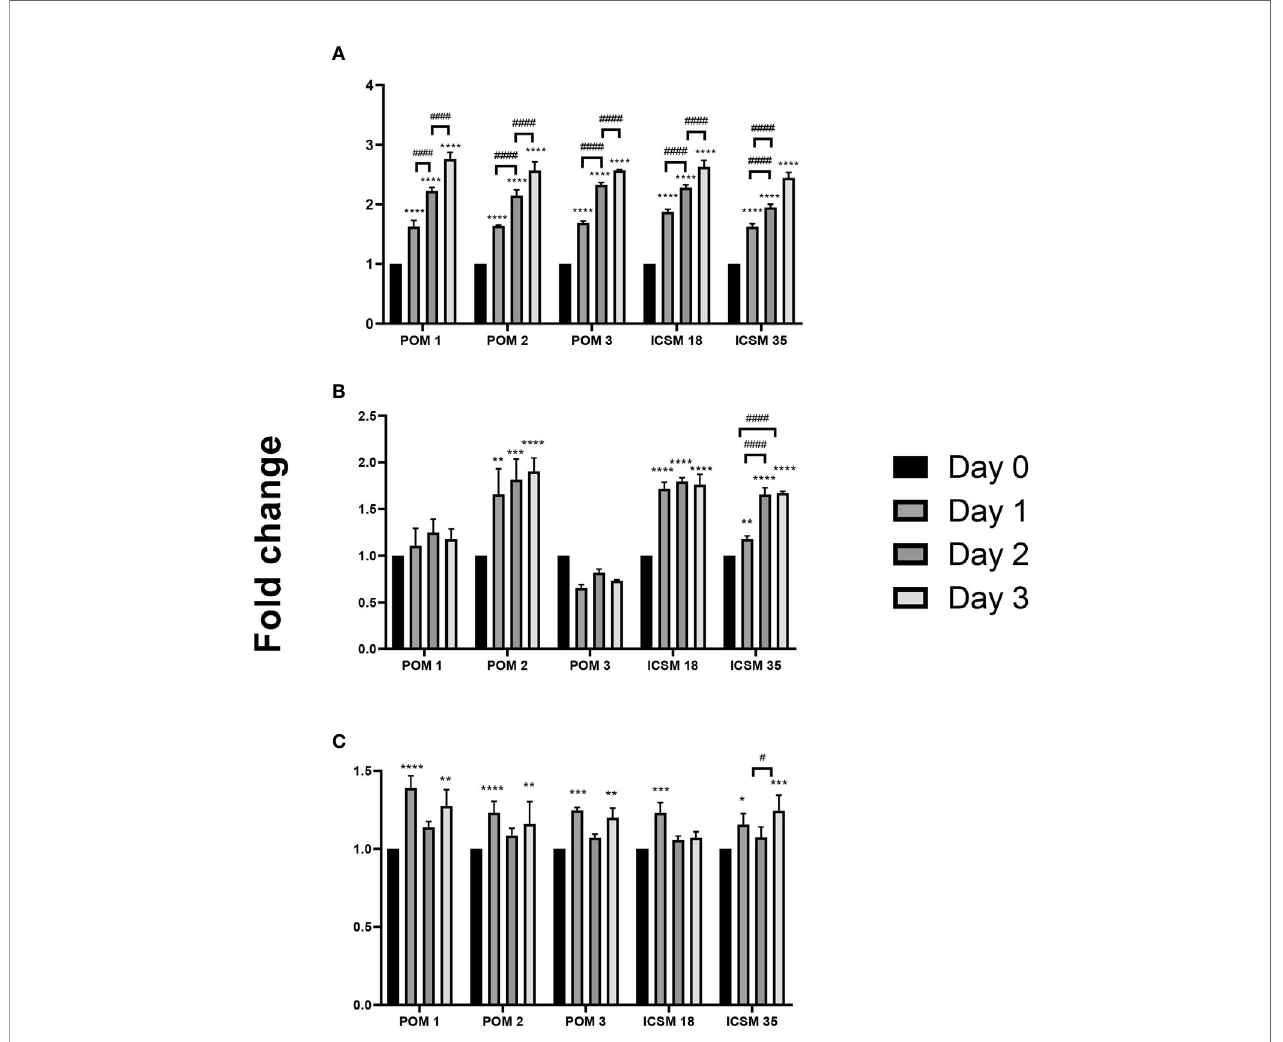
FIGURE 4 | Activation of microglia cells (N11) following treatment with anti-PrP antibodies. Measurement of proin fl ammatory cytokines following direct anti-PrP antibody treatment of mouse microglia (N11) cell line in cell culture supernatant. Herein, fold change of NO (A) , IL-6 (B) and TNF- a (C) production on day 1, 2 and 3 post-antibody treatments compared to untreated cells (day 0). * p < 0.05, ** p < 0.01, *** p < 0.001, **** p < 0.0001 vs. day 0, # p < 0.05, #### p < 0.0001 compared between day 1, 2 and 3. P values were obtained by One-way ANNOVA followed by Tukey ’ s multiple comparisons test analysis by GraphPad Prism